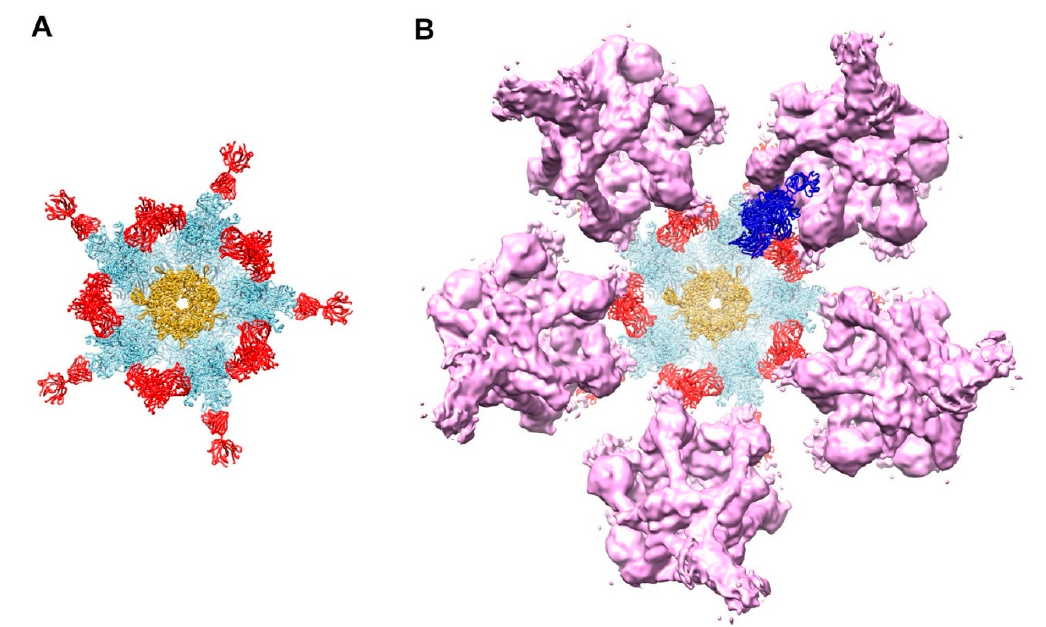
Figure 4. Model for complement C4b near penton base of HAdV-C5 vertex. ( A ) Capsid vertex with a central penton base (gold) surrounded by five peripentonal hexons (light blue) shown with modeled 9C12 Fab fragments (red). ( B ) Capsid vertex with 9C12 Fab fragments modeled with five copies of the IgG-C1 complex (purple) (EMD-4232) [22] near the peripentonal hexons and one copy of complement C4b (blue) (PDB: 4XAM) [39] positioned approximately based on the IgM-C1-C4 structure [19].